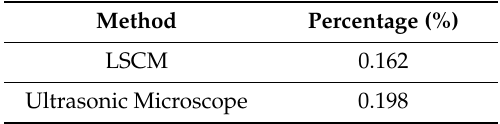
Table 3. Proportion of inclusions area by di ff erent